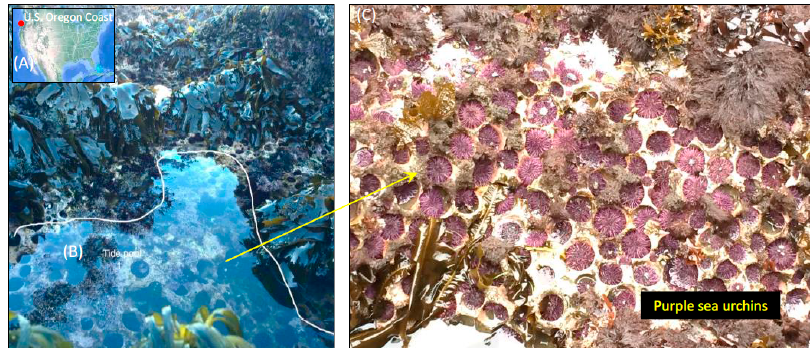
Figure 1. Sample collection site of S. purpuratus (purple sea urchins) from their natural rocky tide pool habitat along the coast of Oregon (43°18'14.3"N 124°24'05.1"W). (A) Satellite image of the collection site (red marker) provided through Google Earth Pro (v.7.3.2.5491) (Data SIO, NOAA, US Navy NGA,